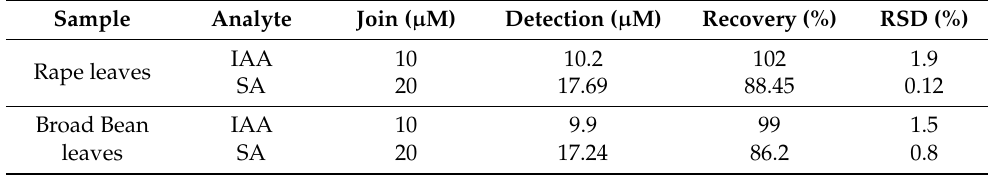
Figure 12. ( a ) LSV (10 consecutive scans) of PPRONPs − CDs − MWCNTs/GCE in 0.1 M PBS (pH = 7) containing 15 μM IAA and 30 μM SA. ( b ) LSV anode current response of five PPRONPs − CDs − MWCNTs/GCE electrodes in 0.1 M PBS (pH=7) containing 15 μM IAA and 30 μM SA. ( c ) LSV anode current response of PPRONPs − CDs − MWCNTs/GCE in 0.1 M PBS (pH = 7) containing 15 μM IAA and 30 μM SA, in the presence of different interferences (10 mM of KCl, ZnSO 4 , CaCl 2 , glucose, CA, AA, L-Arginine), respectively. ( d ) LSV anode current response of PPRONPs–CDs–MWCNTs/GCE in 0.1 M PBS (pH = 7) containing 15 µ M IAA and 30 µ M SA from 1 day to 6 days. Scan rate: 0.1 V/s. Table 3. Determination of IAA and SA in real leaf